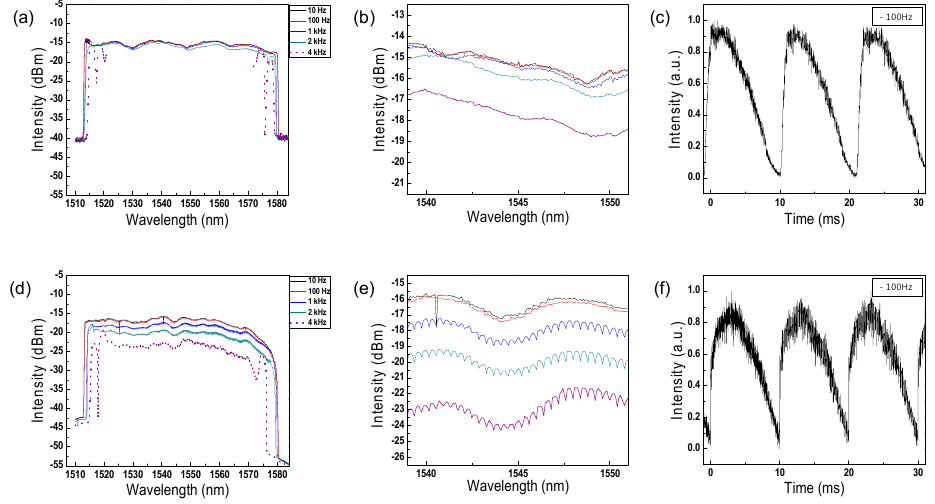
Figure 4. ( a – c ) Conventional WSL with AOTF; ( d – f ) proposed WCSL with AOTF; ( a , d ) Dynamic sweeping output spectra with a repetition rate of 10 Hz, 100 Hz, 1 kHz, 2 kHz and 4 kHz; ( b , e ) magnified spectra from 1539 to 1551 nm. ( c , f ) Time-trace measurement of the sweeping output at a repetition rate of 100 Hz.